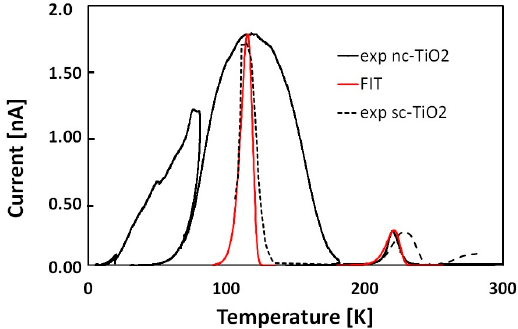
Figure 4. Fractional TSC measured with the nc-TiO 2 film in the range 5–300 K compared with experimental TSC peaks reported in [29] for single crystal TiO 2 and with a best fit obtained considering a standard TSC emission from discrete energy levels. The experimental peaks for sc-TiO 2 have been multiplied respectively by 1700 (120 K) and 500 (230 K) to compare with those measured with the nc-TiO 2